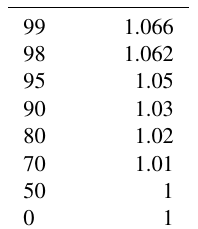
Table 3. Hygroscopic growth factors (HGFs) for black carbon (based on Lei et al.,